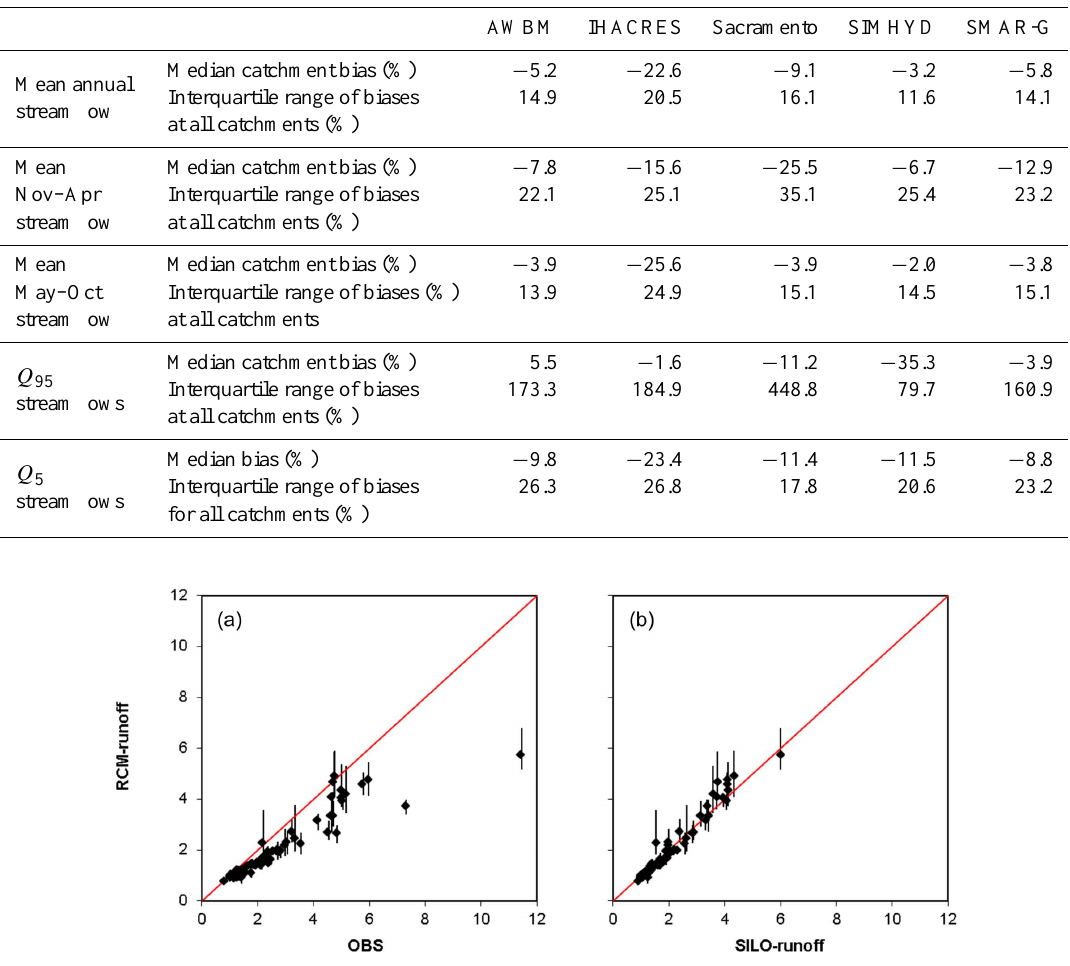
Table 1. Summary of biases of hydrological models forced by CCAM calculated at 86 streamflow gauges from the average of the six RCM simulations.